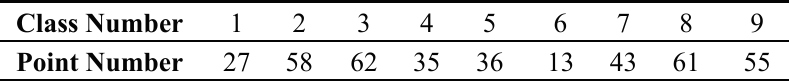
Table 1. Number of sampling points in each